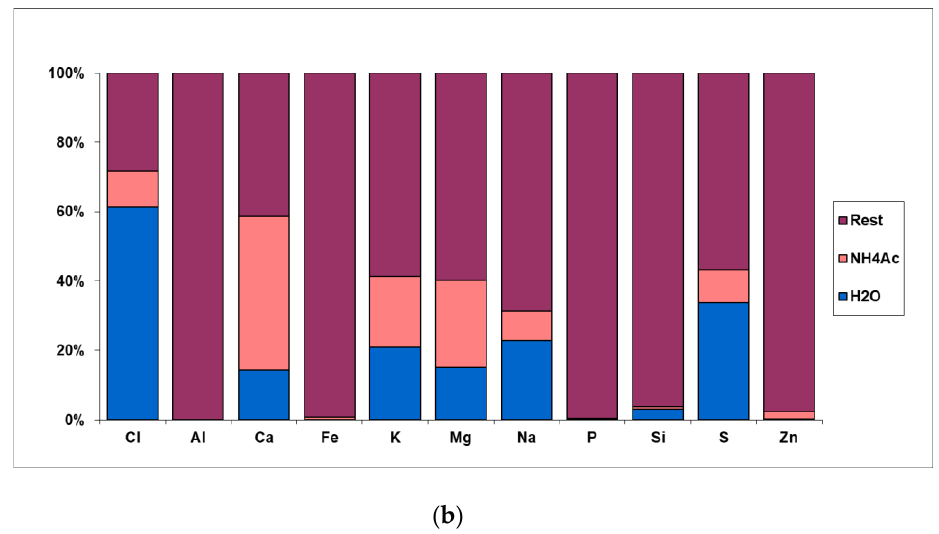
Figure 10. Prediction of the percentage of non-reactive and reactive fractions of the ash-forming elements in the char: ( a ) LSS and ( b ) BSS.